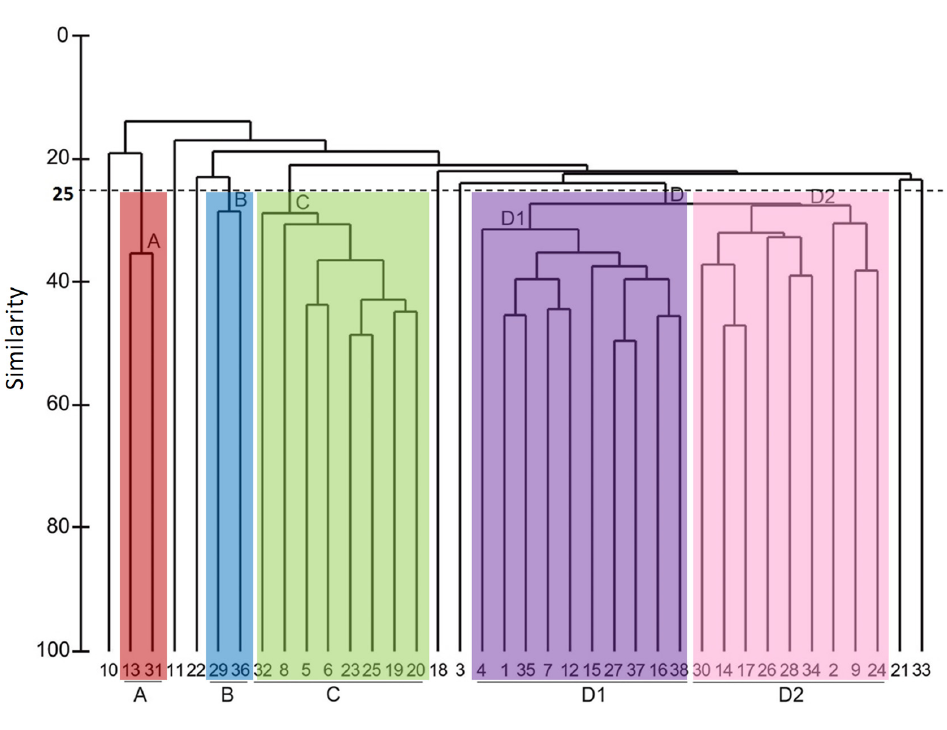
Figure 3. Hierarchical cluster analysis for benthic macrofauna at the ACS.